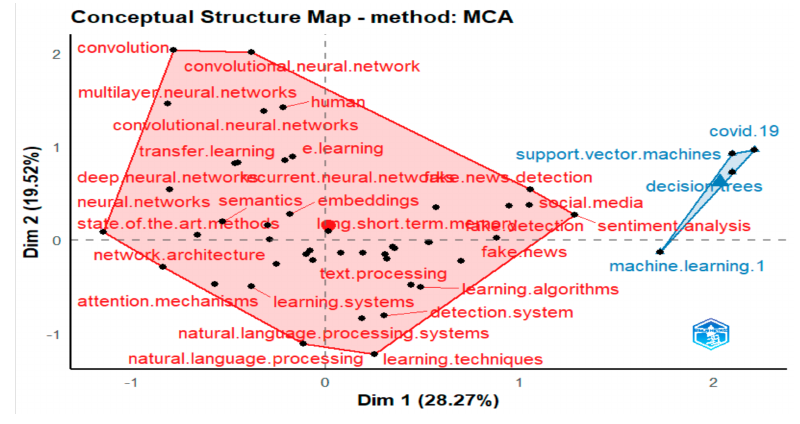
Figure 19. Factorial analysis.